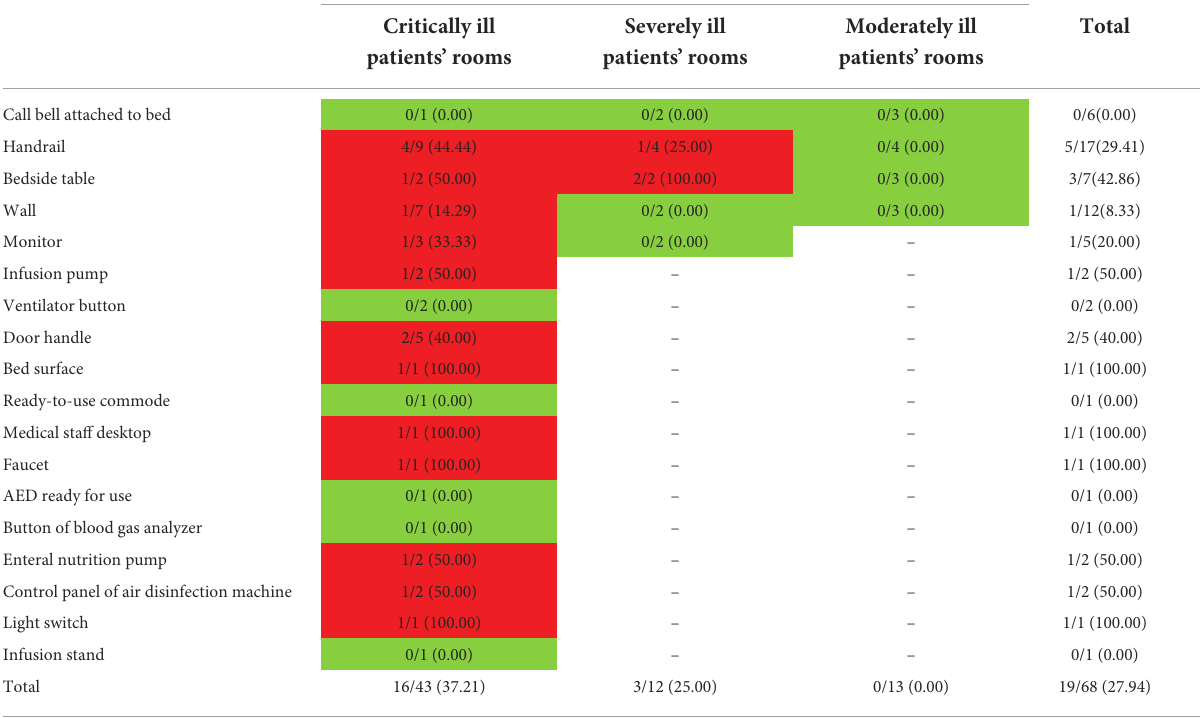
TABLE 2 Results of SARS-CoV-2 testing in infection isolation rooms before the intervention. Sites